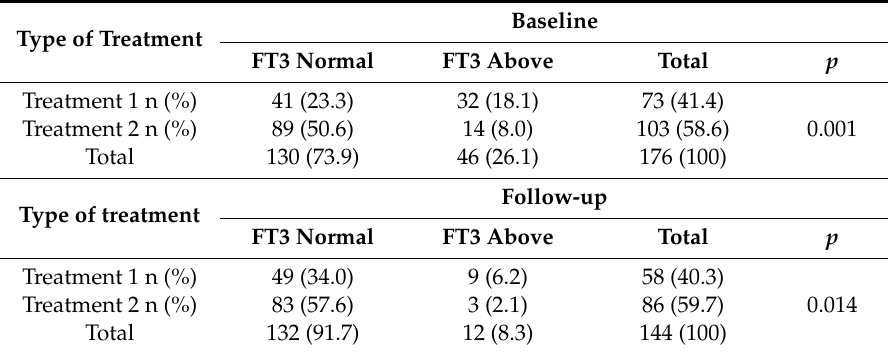
Table 3. Distribution of individuals according to FT3 values a .